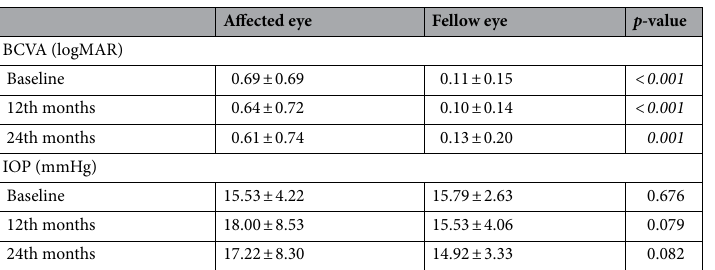
Table 2. Best corrected visual acuity and IOP variances. Values are presented as mean ± standard deviation unless otherwise indicated. BCVA best-corrected visual acuity, logMAR logarithm of the minimum angle of resolution, IOP intraocular pressure. Comparison between affected and fellow eyes during each period. P -value derived from the paired two-tailed t-test. Significant values are in